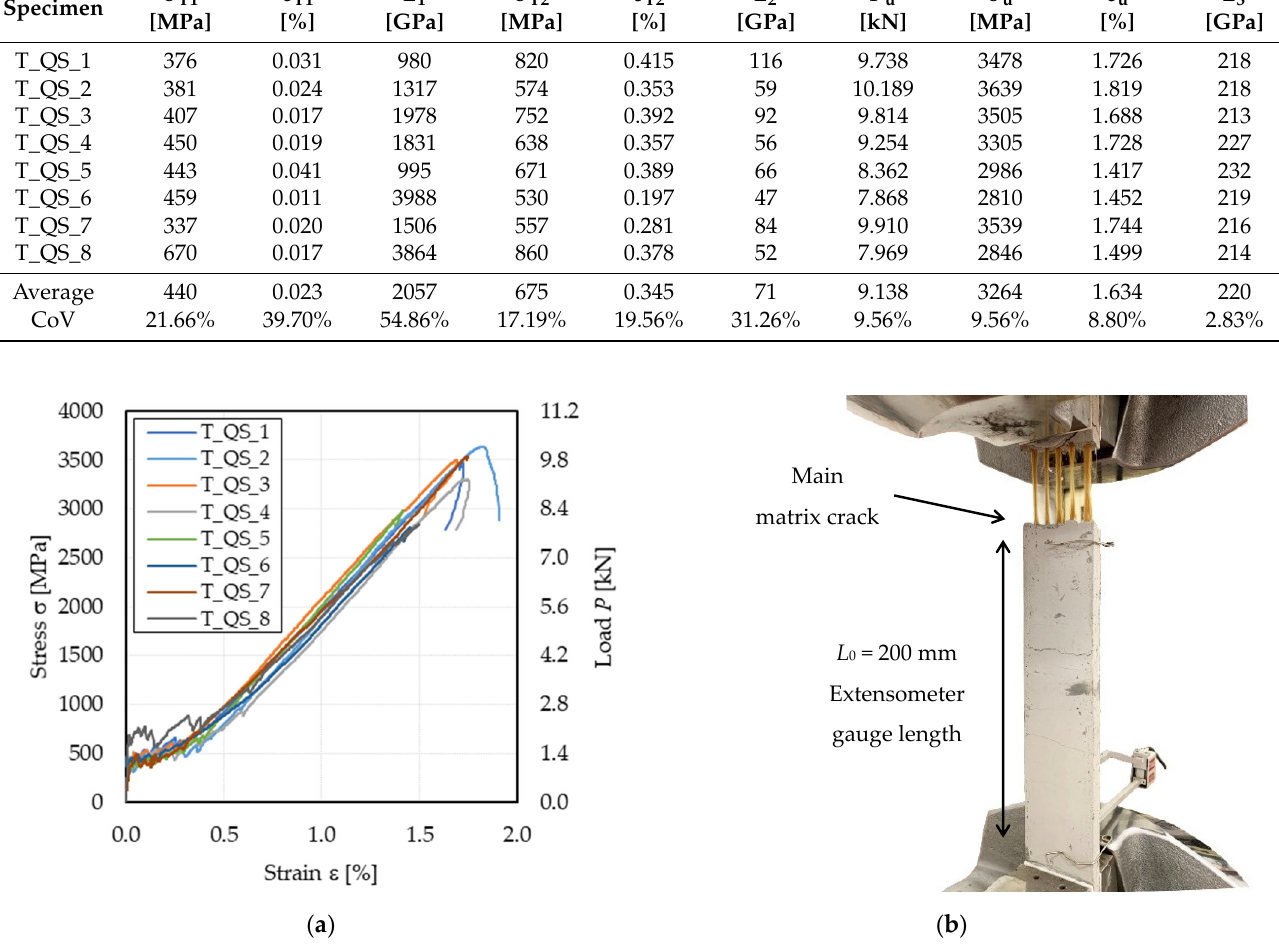
Figure 2. Quasi-static tests: ( a ) stress (load)–strain curves; ( b ) failure of specimen T_QS_1.